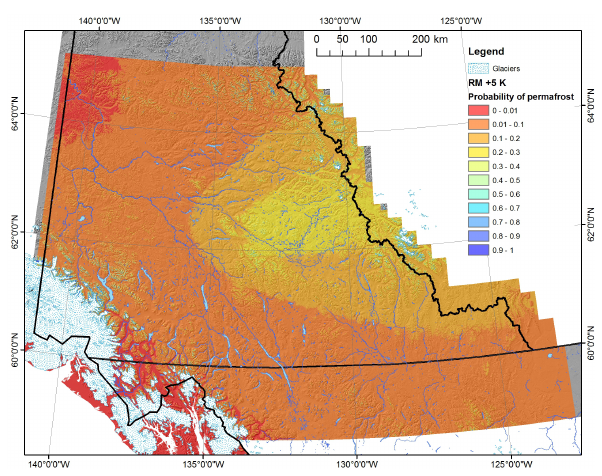
Fig. 7. Regional model permafrost probability map under a + 5K climate change scenario. Permafrost underlies 9% of the region un- der this